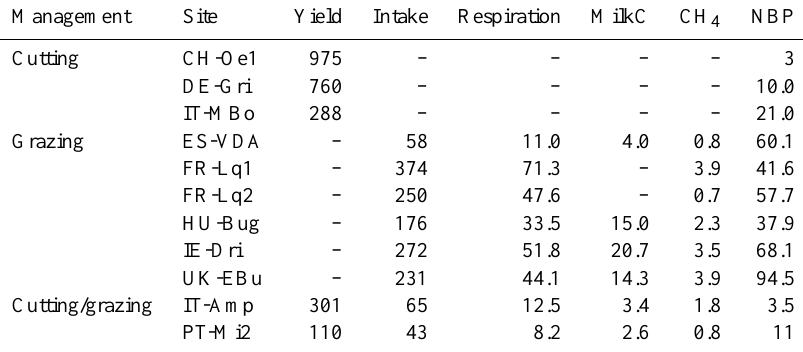
Table 4. Model output related to management from ORCHIDEE-GM. Yield, mean annual forage production (dry matter, gm − 2 yr − 1 ) ; intake, mean annual grass mass digested by animals (dry matter, gm − 2 yr − 1 ) ; respiration, mean annual animal respiration (C, g m − 2 yr − 1 )